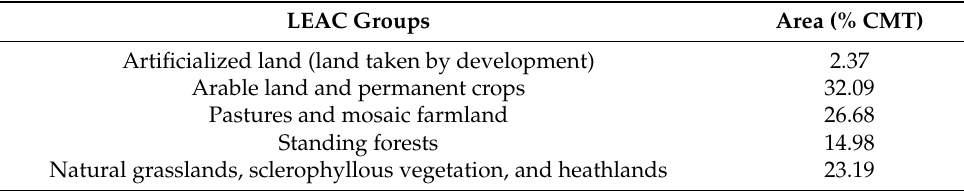
Table 4. LEAC groups as share of the Coghinas-Mannu-Temo subdistrict.